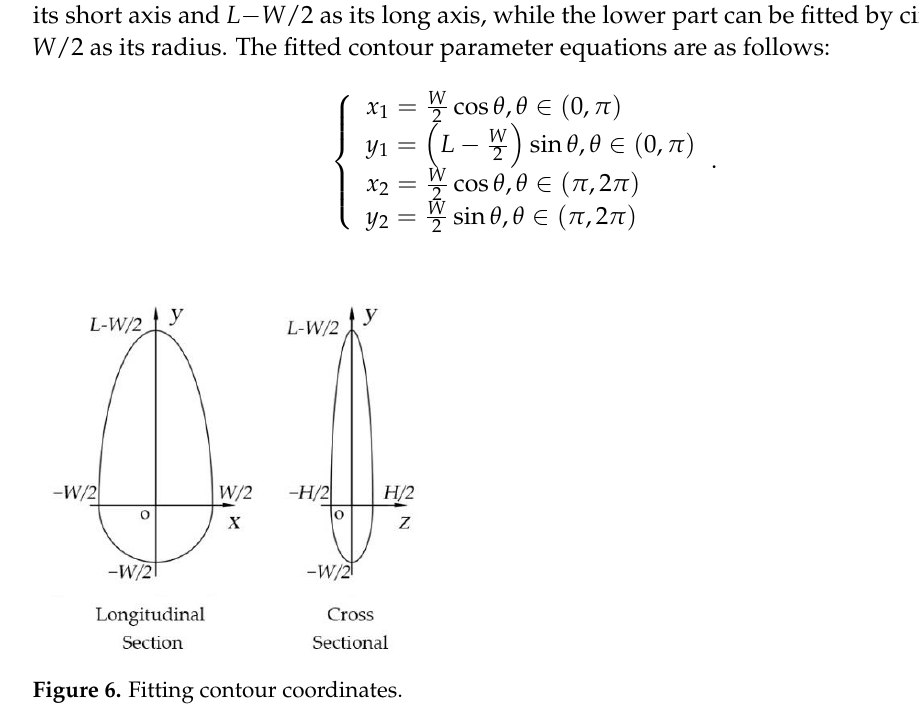
Figure 5. Profile Extraction Fitted Curve Plot: ( a ). Original image of longitudinal section; ( b ). Binary image of longitudinal section; ( c ). Longitudinal profile curve; ( d ). Longitudinal profile curve and fitted curve; ( e ). Original image of cross-section; ( f ). Cross-sectional binary image; ( g ). Cross-sectional contour curves; and ( h ). Cross-sectional contour curves and fitted curves.